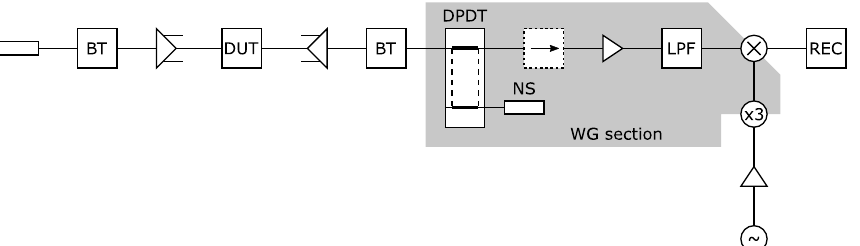
Figure 6. V-band cold-source noise test bench: block diagram. From the left to the right along the measurement chain: (cold) matched termination, input bias-T, input RF probe, DUT, output RF probe, output bias-T, DPDT switch, ferrite isolator, pre-amplifier, low-pass filter, mixer, receiver. The DPDT switch is in addition connected to a solid-state noise source. The LO port of the mixer is driven by the cascade of a signal source, an amplifier and a frequency